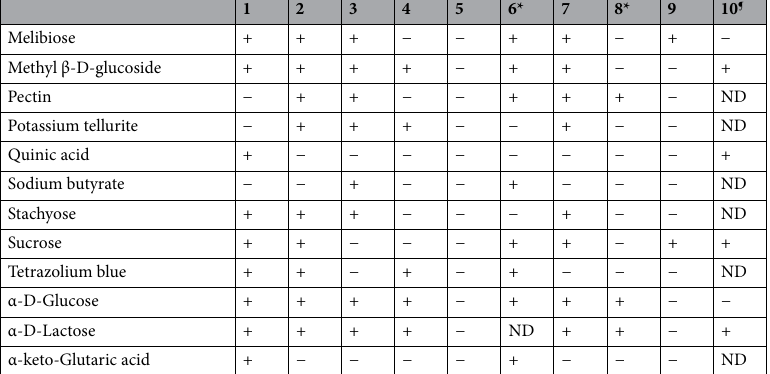
Table 2. Differential biochemical characteristics of novel strains SS9-22 T , W9P-11 T , SW1-E11 T and other species in genus Fulvivirga . Taxa: 1, SS9-22 T ; 2, W9P-11 T ; 3, SW1-E11 T ; 4, F. sediminis 2943 T ; 5, F.